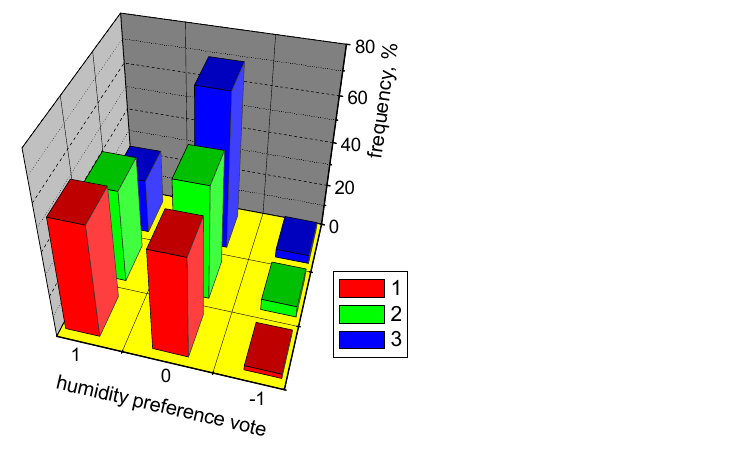
Figure 8. Distribution of humidity preference votes in the Courthouse (1), “A” building (2) and “Energies” (3).